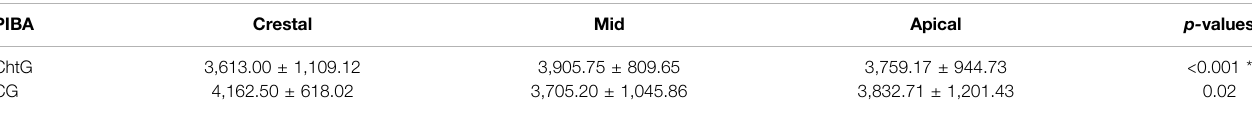
TABLE 2 | Speci fi c crestal, mid and apical trends in the experimental and control groups for PIBA (mean ± deviation). PIBA Crestal Mid Apical